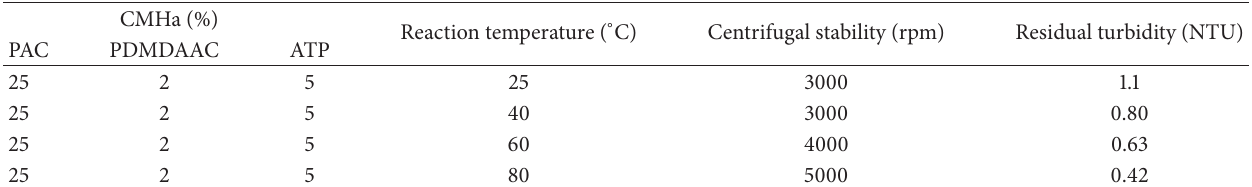
Table 4: The influence of reaction temperature on the stability and the coagulation behavior for the produced samples (1000NTU diatomite suspension).